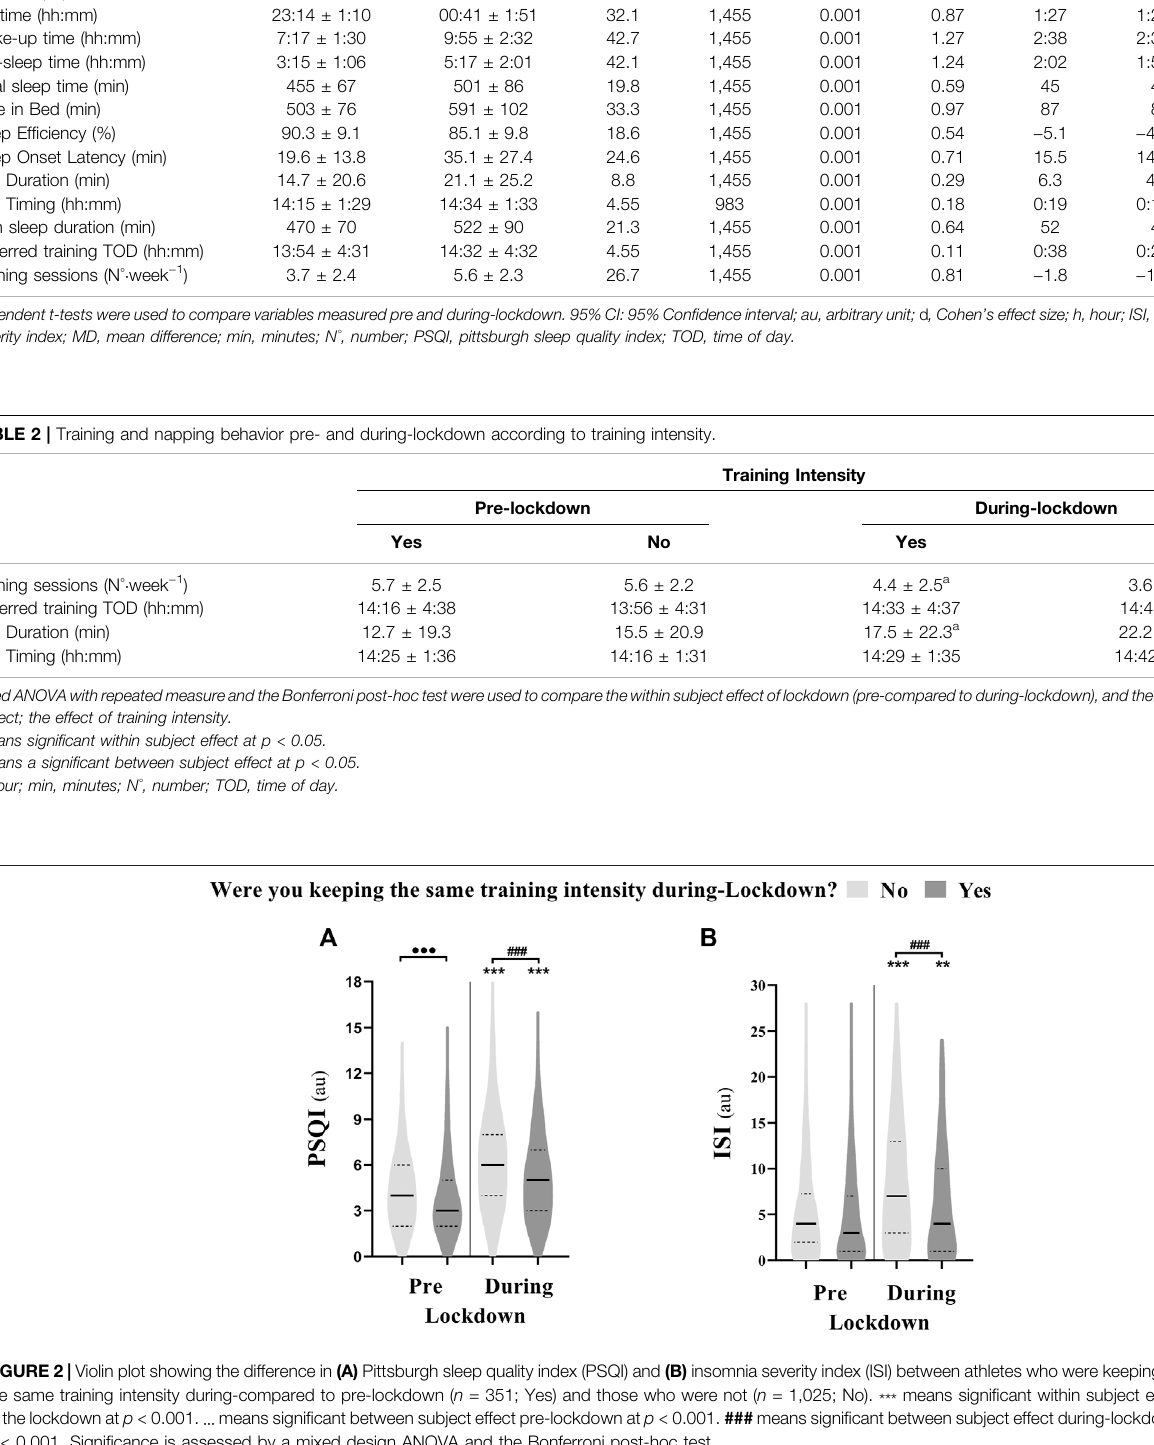
Frontiers in Physiology |